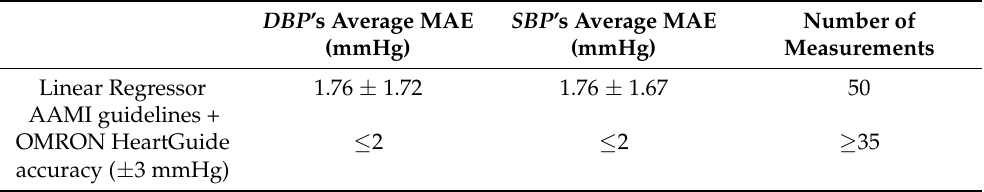
Table 4. Comparison of the results related to the SHIMMER database and the AAMI